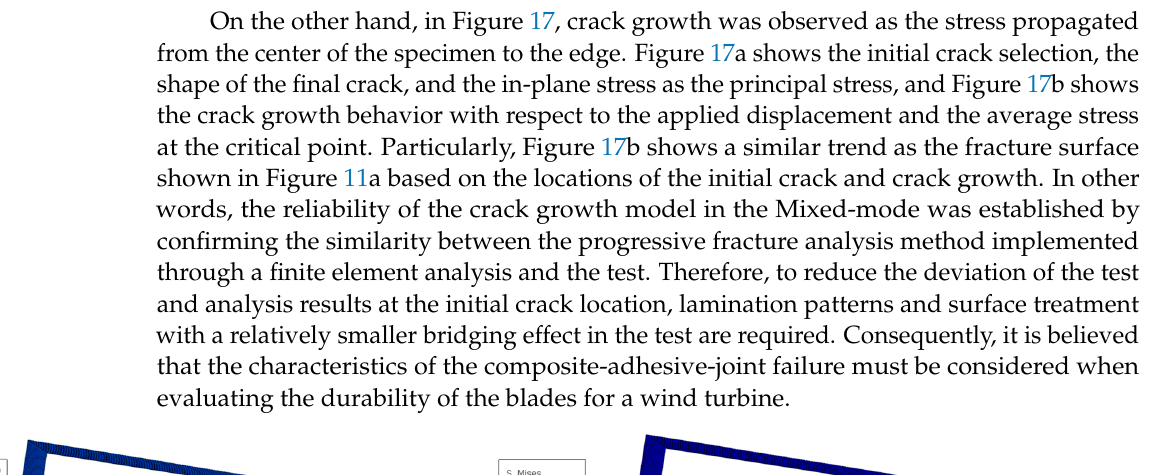
( a ) P −𝛿 curve and ( b ) G (I+II) − a curve. ( a ) P − δ curve and ( b ) G ( I + II ) − a curve.